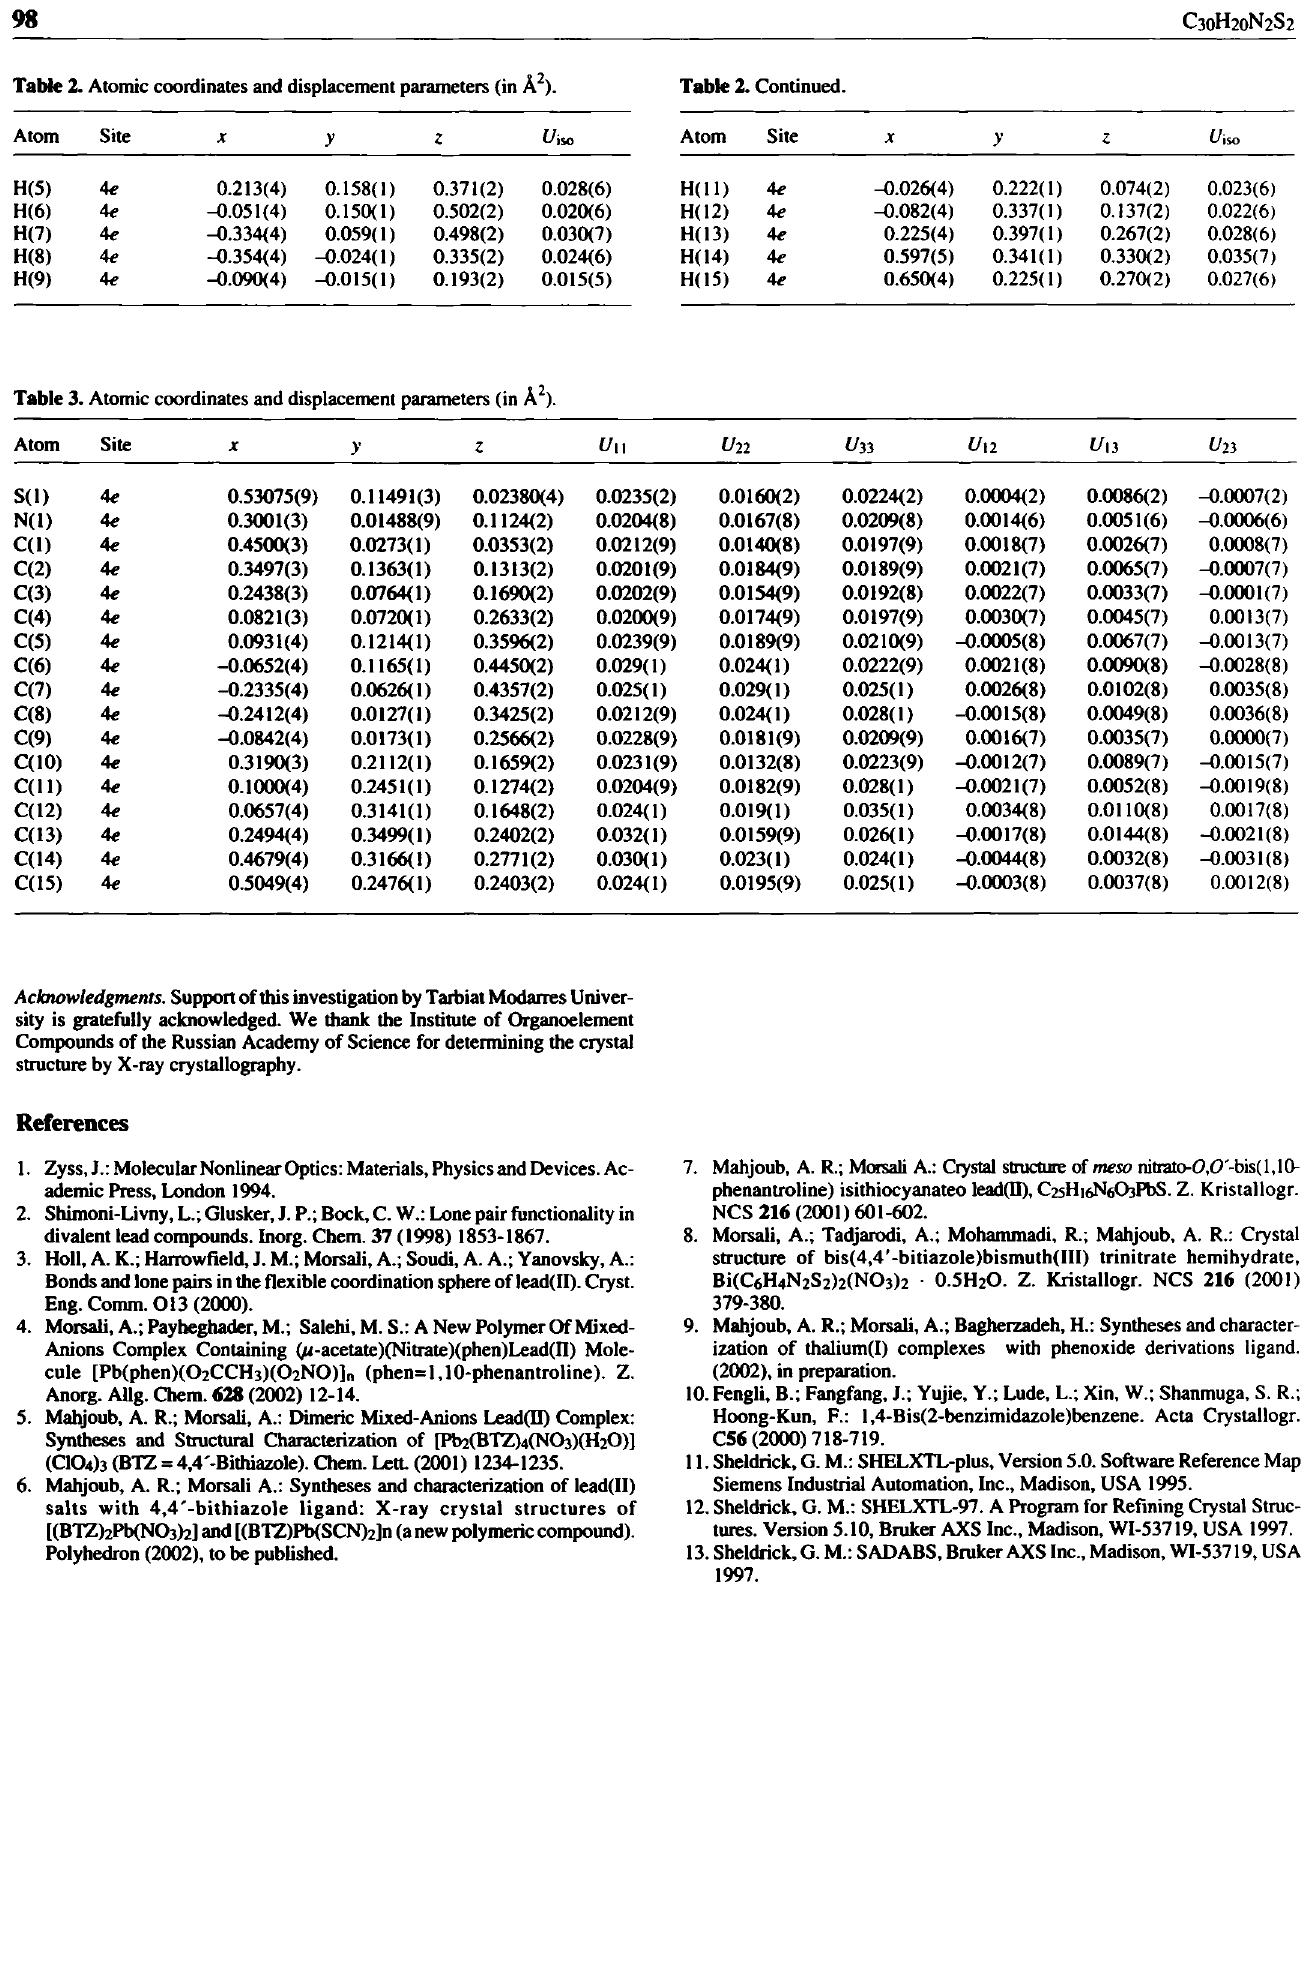
Table 2. Atomic coordinates and displacement parameters (in Â 2 ).